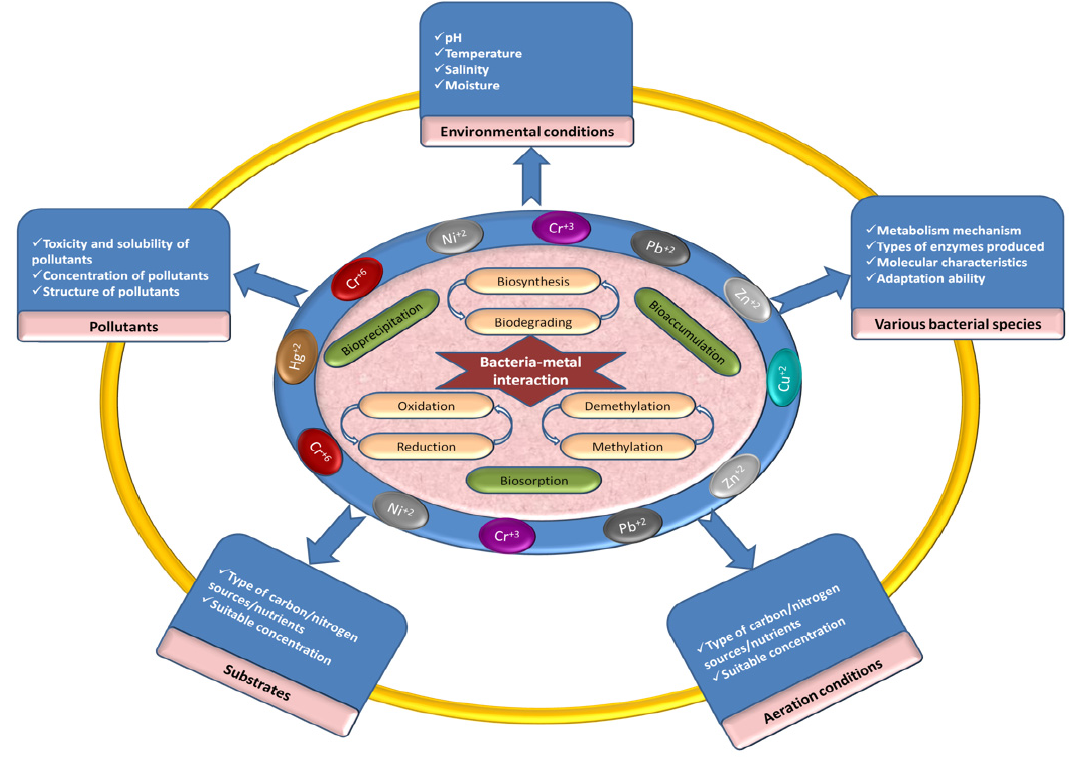
Figure 2. Factors affecting the bioremediation process .